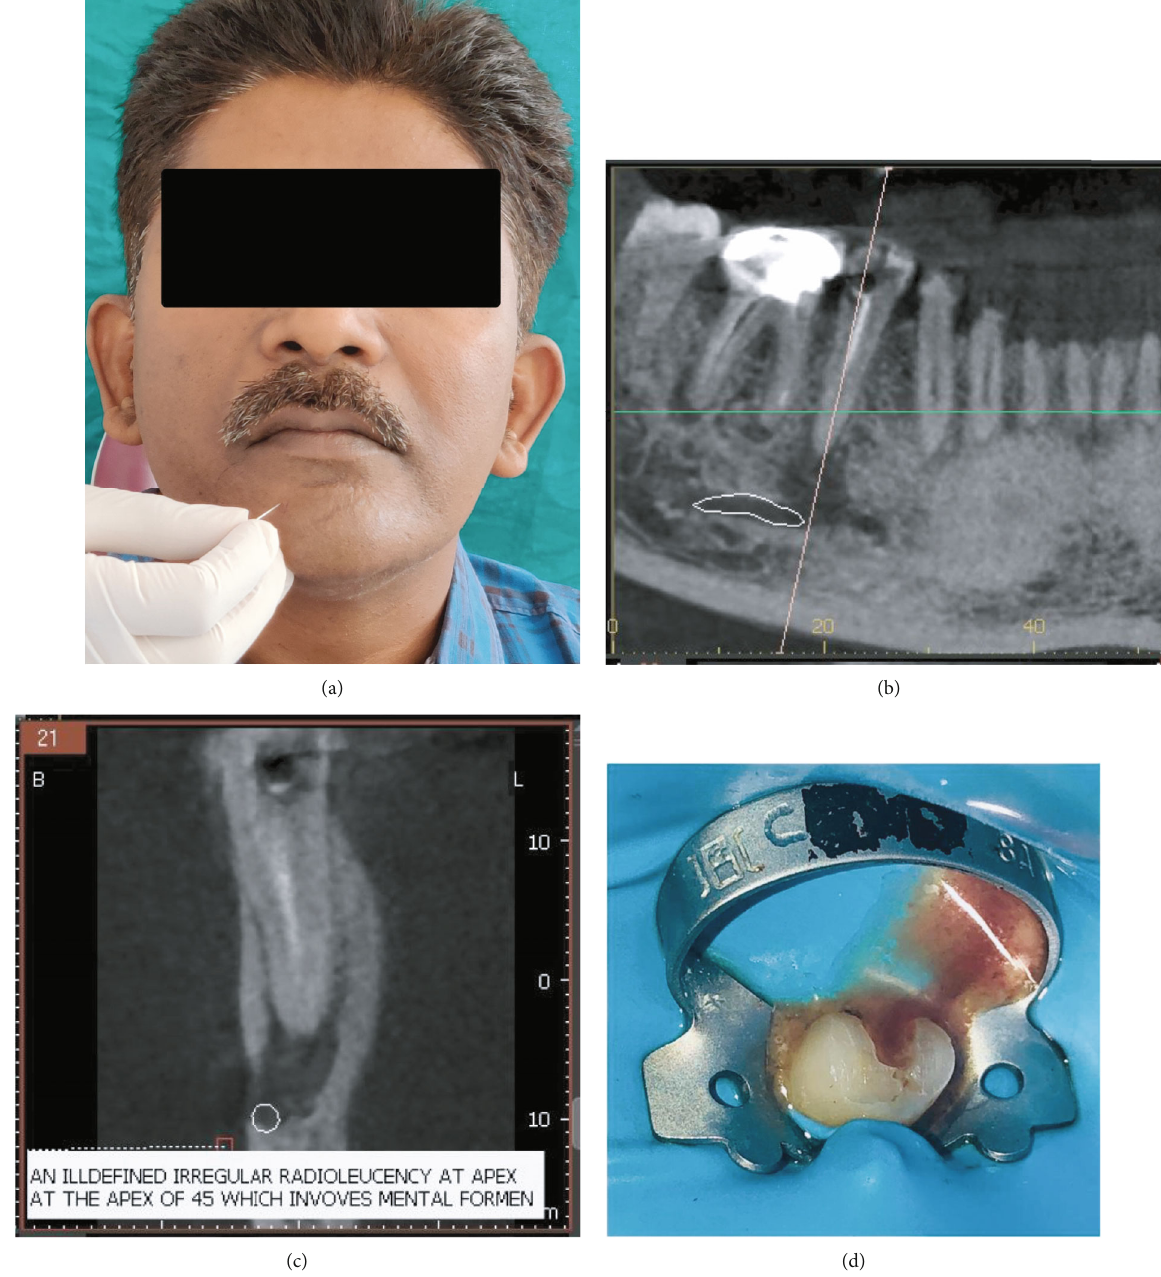
Figure 3: (a) Paraesthesia testing, (b, c) preoperative CBCT, and (d) access cavity under rubber dam